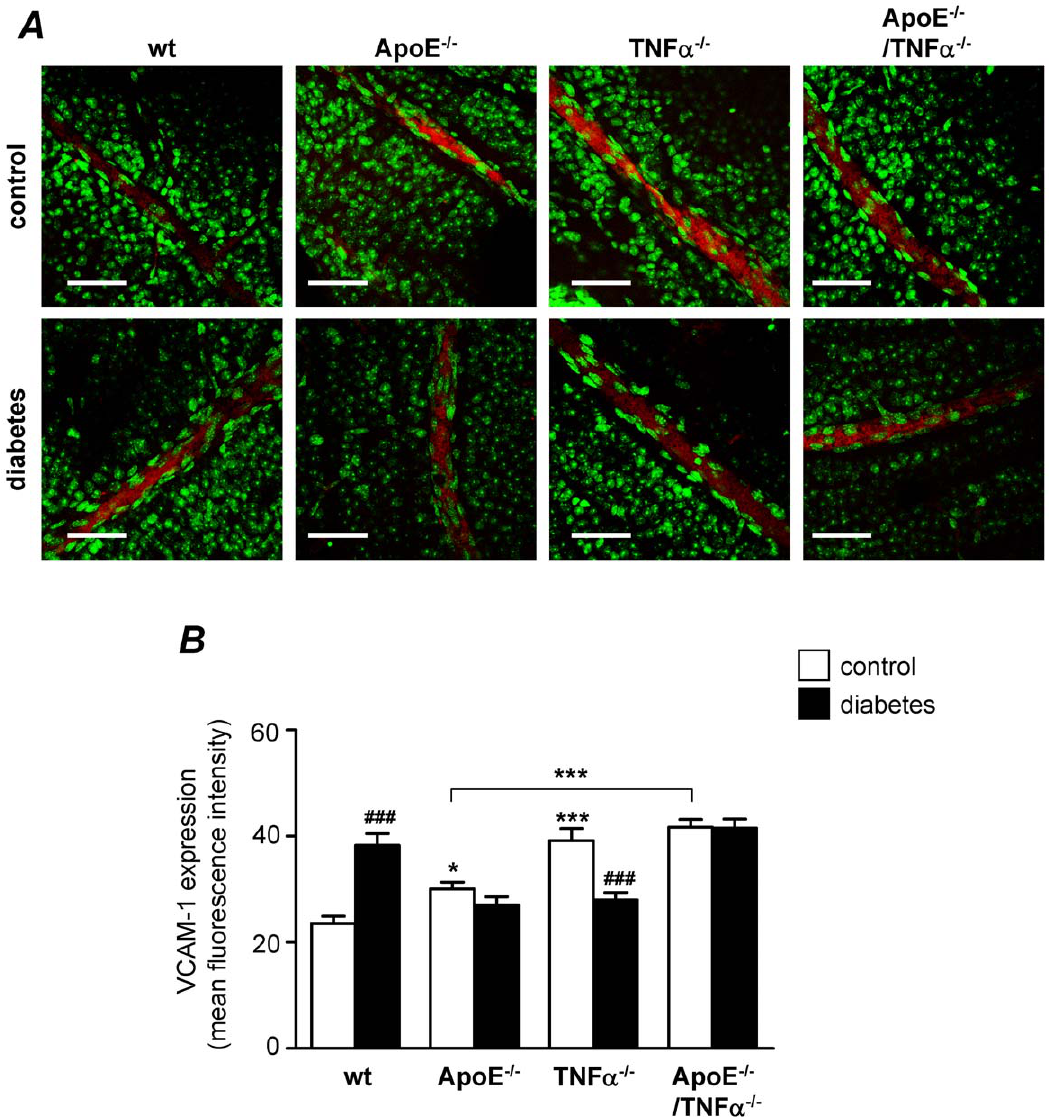
Figure 1. Effects of diabetes on VCAM-1 protein expression in retinal vessels. ( A ) Confocal immunofluorescence microscopy images showing VCAM-1 staining (red) in retinal whole-mounts from control non-diabetic and diabetic wild type (wt), ApoE 2 / 2 , TNF a 2 / 2 and ApoE 2 / 2 / TNF a 2 / 2 mice. The DNA-binding dye SYTOX (green) was used for nuclear localization. Bars=50 m m. Measurements were performed 8 weeks after the first STZ-injection, when mice were 30 weeks of age. ( B ) Summarized data from experiments in A showing mean fluorescence intensity of VCAM-1 in the different groups. White bars represent control and black bars diabetic mice. Two-way analysis of variance (for the effects of diabetes and genotype) revealed significant interactions between factors. Bonferroni posttests yielded * p , 0.05 and *** p , 0.001 for comparisons between ApoE 2 / 2 and TNF a 2 / 2 , respectively vs. wt control; *** p , 0.001 for comparison between ApoE 2 / 2 and ApoE 2 / 2 /TNF a 2 / 2 ; and ### p , 0.001 for comparisons between control and diabetes of the same